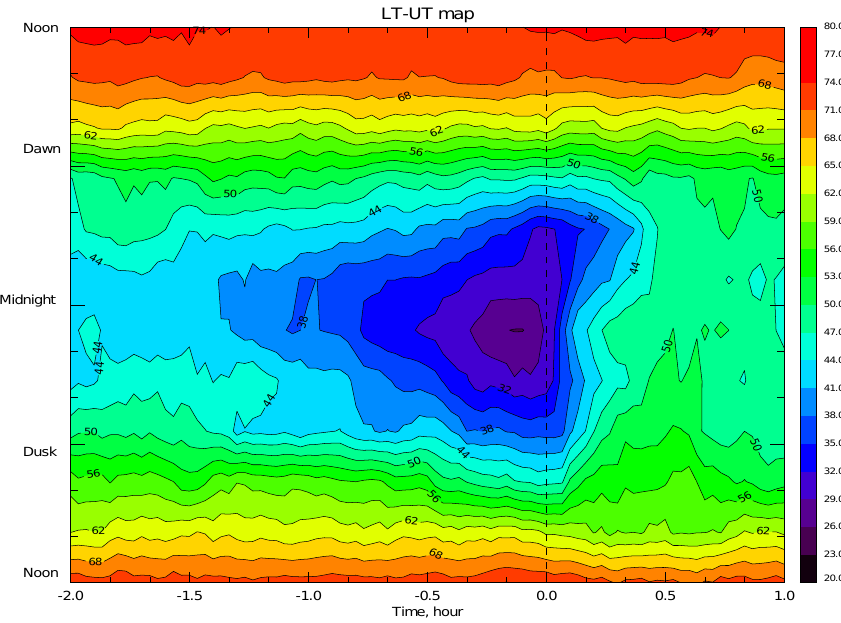
Fig. 4. Local time–universal time contour plot of the tilt angle during individual teeth. See Fig. 3